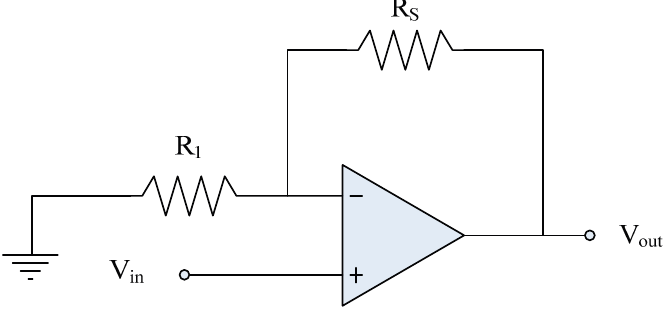
Figure 2. Readout circuit for the methanol sensor.